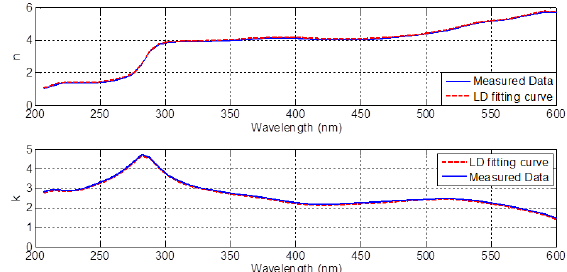
Figure 10. Experimental [11] and fitted Lorentz-Drude model for the real and imaginary parts of the Germanium refractive index in the first sub-band